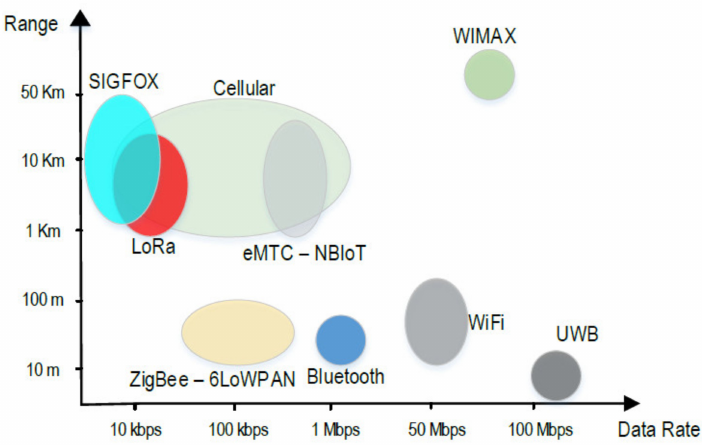
Figure 5. Comparison of different wireless topologies as a function of distance and